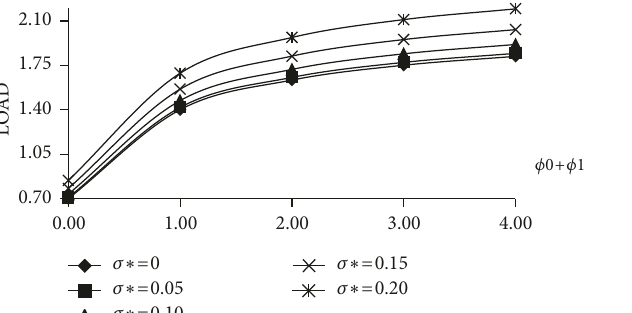
Figure 11: Variation of load carrying capacity with respectto 𝜎 ∗ and 𝛼 ∗